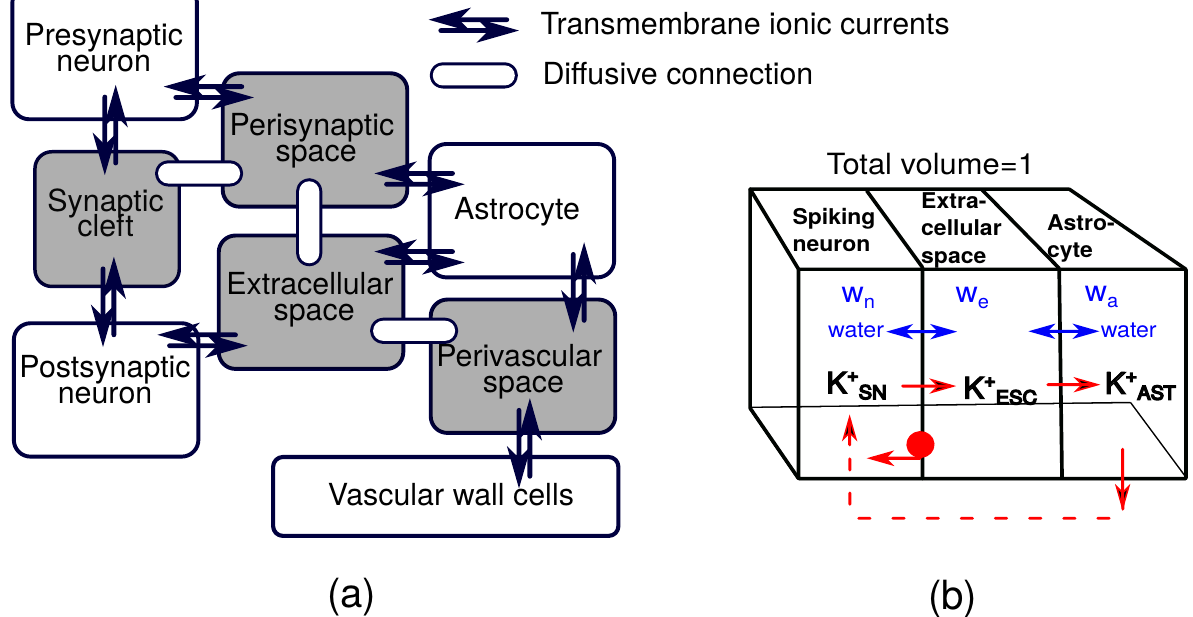
Figure 1. ( a ) Flowchart of the major interaction pathways within a neurovascular unit (NVU). Volume compartments are shaded grey. See text for further details. ( b ) Minimalistic representation of the same system contains only three key compartments: spiking neuron, extracellular space, and